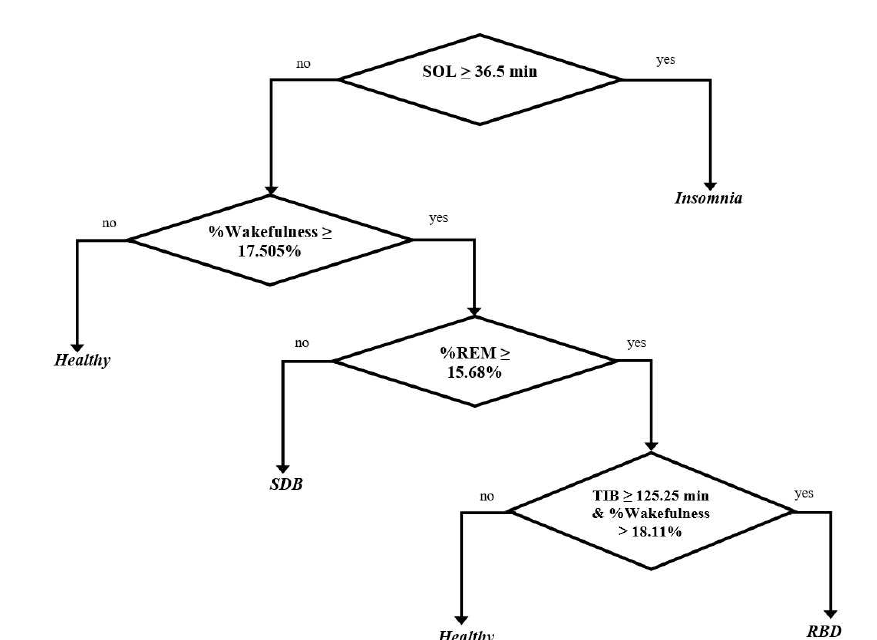
Figure 6. The trained model of the ensemble of bagged tree classifier in classifying four classes of sleep